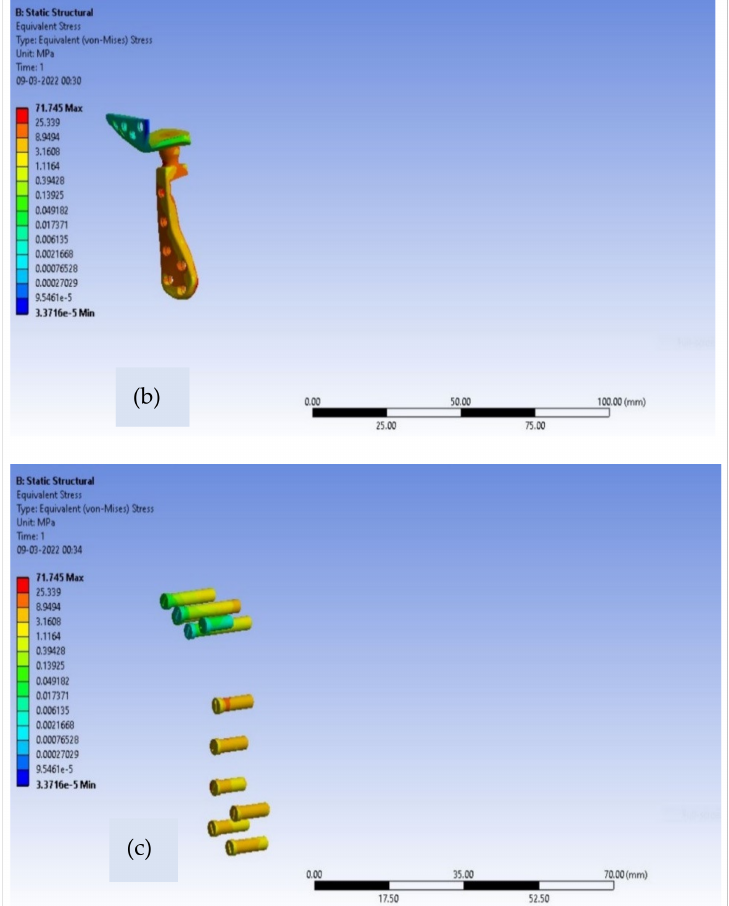
Figure 7. The von-Mises stress contours for ( a ) Total TMJ prostheses with mandible ( b ) Condylar and fossa parts without screws ( c ) fossa and condylar screws in case of Co-Cr alloy model of customized TMJ prostheses.